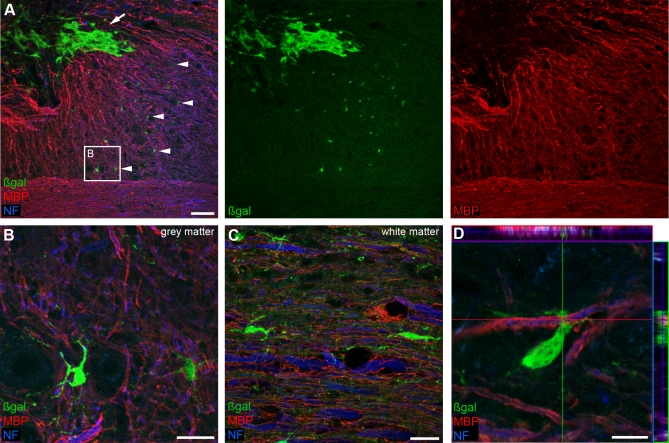
Ependymal Cells Give Rise to Oligodendrocytes after Injury(A) Ependymal cell-derived progeny are most abundant within the core of the scar tissue forming at the injury (arrow). Ependyma-derived cells are also found, more sparsely, over a larger area in the intact tissue bordering the lesion (arrowheads), where they are associated with myelin basic protein (MBP)-immunoreactive myelin ensheathing neurofilament (NF)-immunoreactive axons.(B–D) Ependymal cell-derived progeny harboring an oligodendrocytic morphology are found both in the grey (B) and white matter (C), and some recombined processes wrap around myelinated axon (D).Scale bars indicate 100 μm in (A), 25 μm in (B) and (C), and 10 μm in (D).